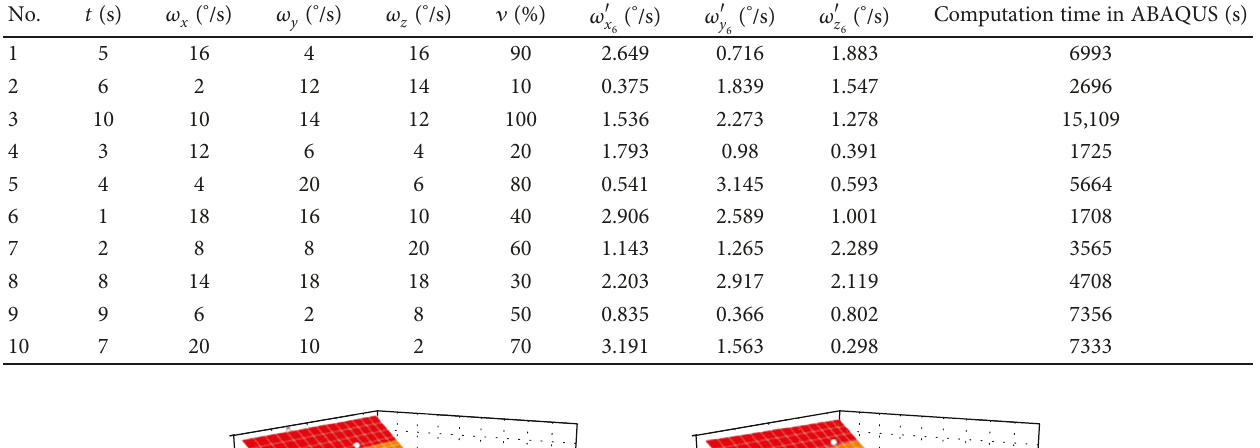
Table 20: Simulation results of liquid storage tank and microsatellite with the deployment mechanism.